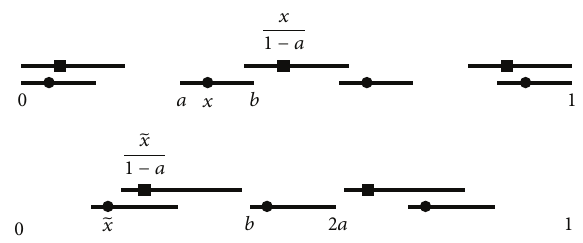
Figure 3: Scheme of summation intervals placement for (7) (upper) and (8) (lower), here 𝑏 = 1 − (𝑛 − 1)𝑎 , odd 𝑛 .